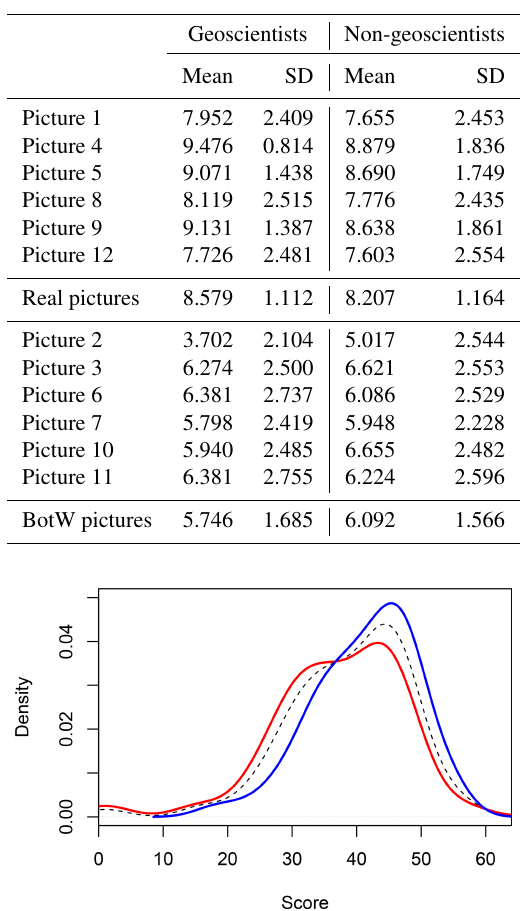
Table 1. Average rating and SD per picture for geoscientists and non-geoscientists. The first six rows concern real pictures, the last six BotW pictures.